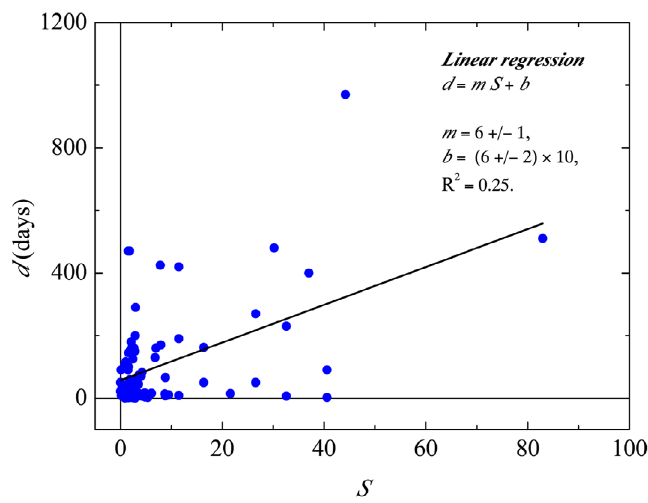
Figure 4. Linear regression of d as a function of S